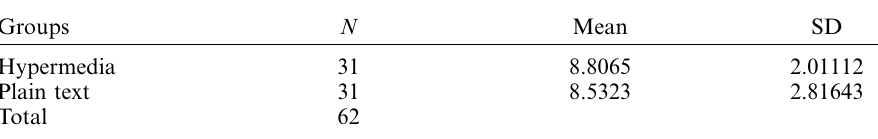
Table 1. Descriptive statistics for pre-test.